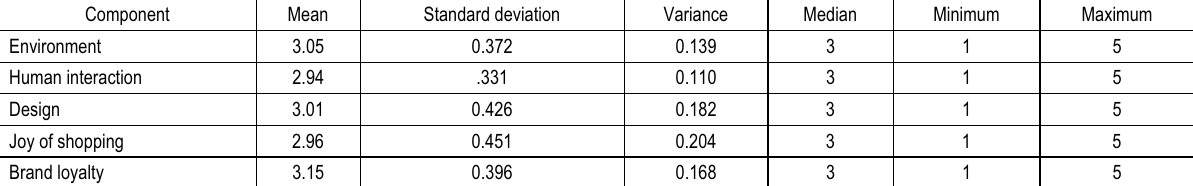
Table 1. Descriptive results of questionnaire